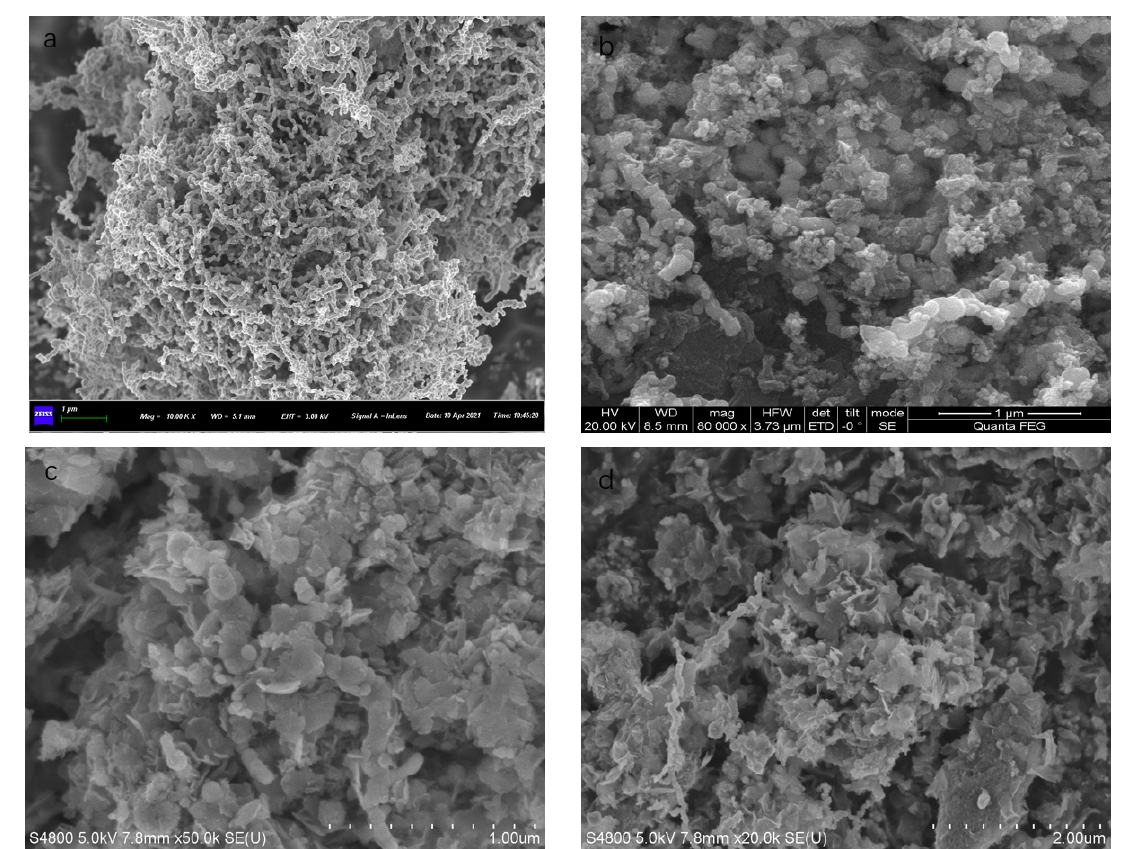
Figure 5. SEM images of Fe/Cu ( a ) and rGO/Fe/Cu ( b ) and the rGO/Fe/Cu at 1 um ( c ) and 2 um ( d ) after the experiment.